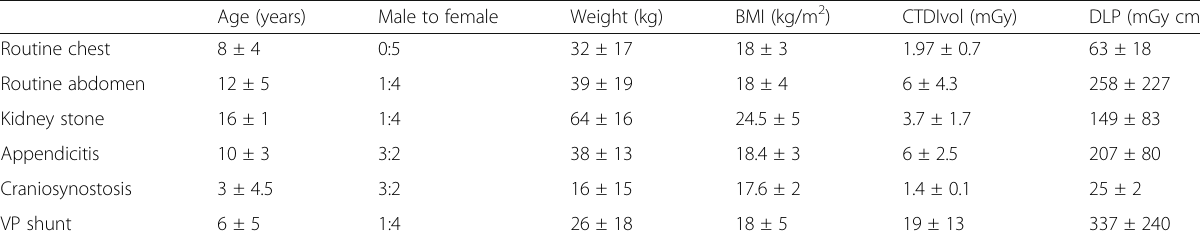
Table 2 Mean ± standard deviation of age, gender, weight, and body mass index (BMI), CTDI vol , and DLP of patients included in the study